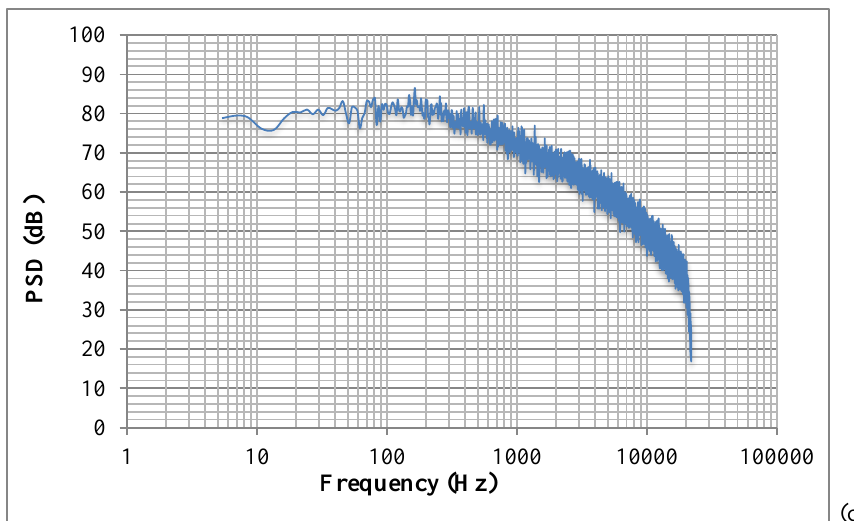
Figure 4. The maximum sound pressure level measured in outdoor test: (a) 120 km/h, (b) 100 km/h, and (c) 80 km/h